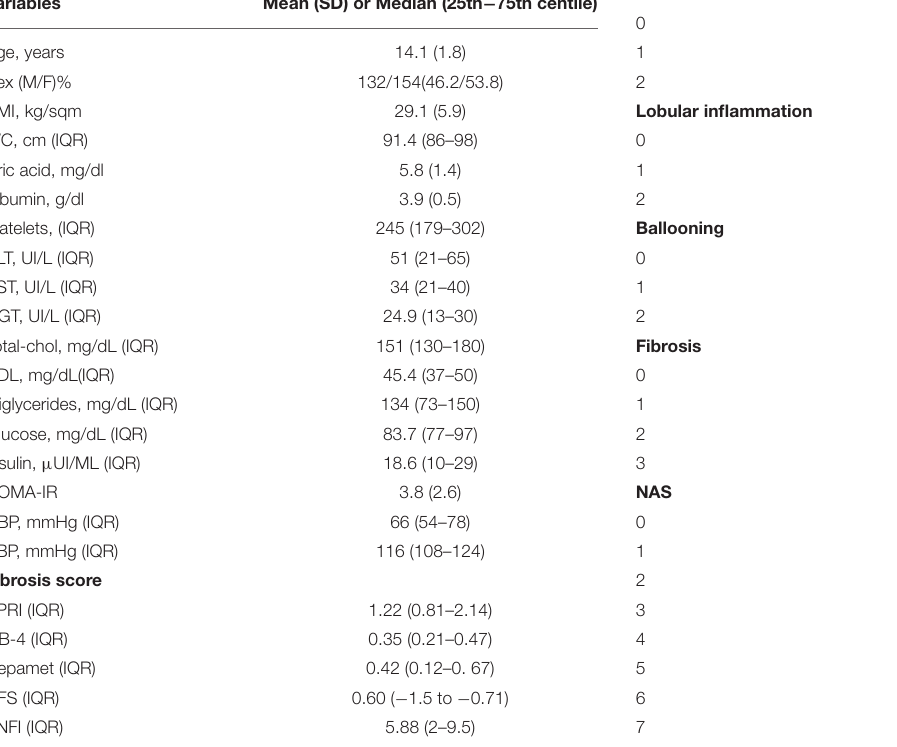
TABLE 1 | Anthropometric, laboratory characteristics, and scores values of population.